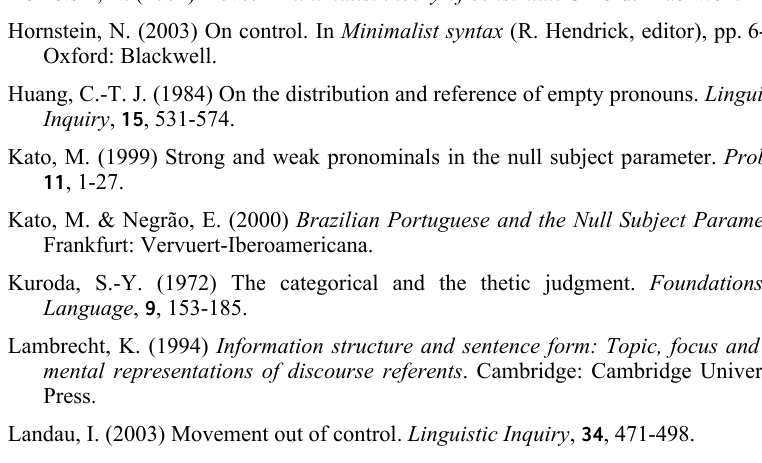
Figueiredo Silva, M. C. (1994) La position sujet en Portugais Brésilien. Doctoral dissertation, Université de